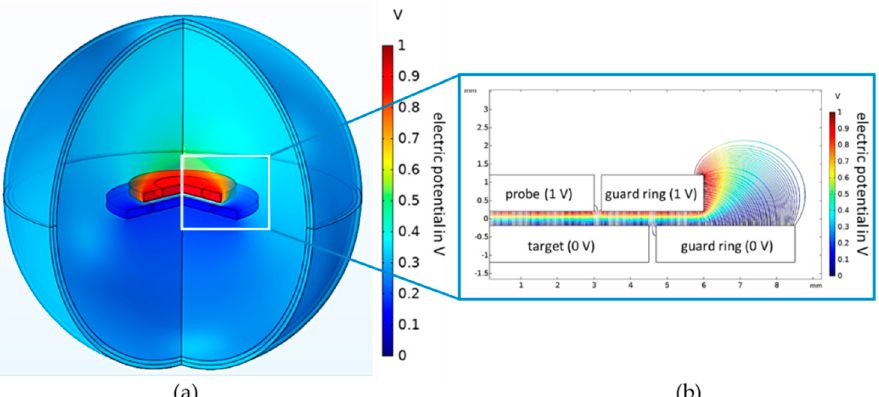
Figure 5. FEM simulation result of the parallel plate capacitor with guard ring electrodes. ( a ) electric potential distribution of the complete model. ( b ) propagation of the electric field lines. There are fringe fields at the edges of the guard rings. The distortions of the field lines at the edges of the working electrodes are much smaller.